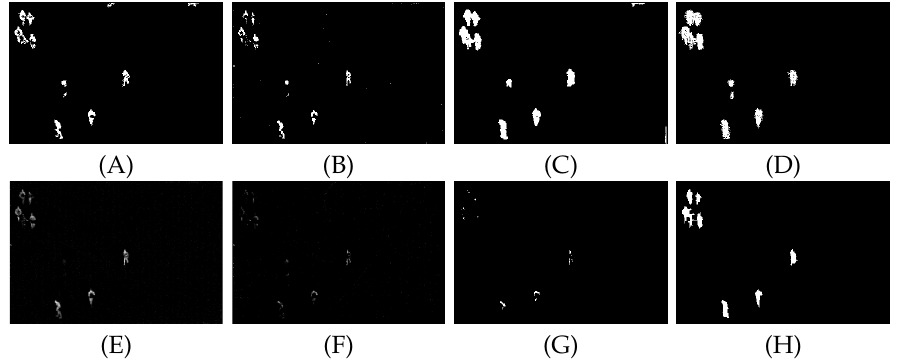
Figure A9. ( A – H ) shows the detection results of eight algorithms PSTNN, TV-PCP, VNTFR, anisotropy, ASTTV, SRWS, RPCA and propose method, respectively, under sequence C.